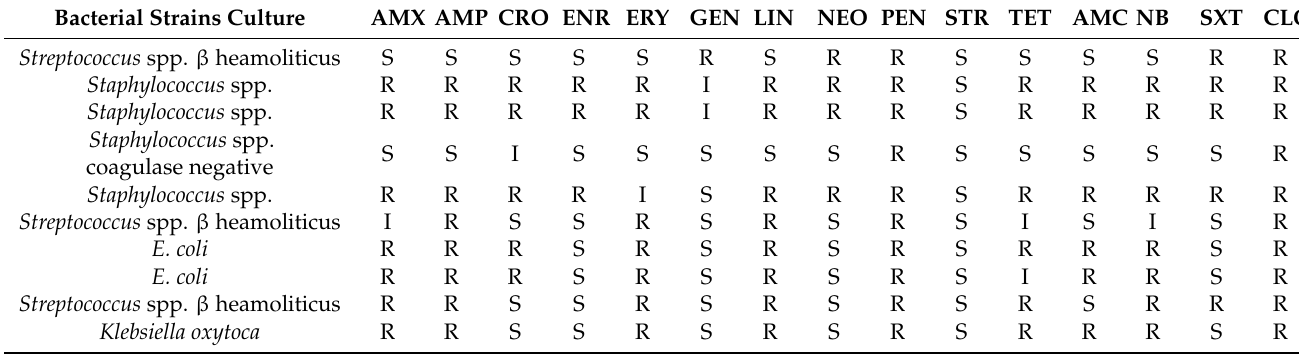
Streptococcus spp. β